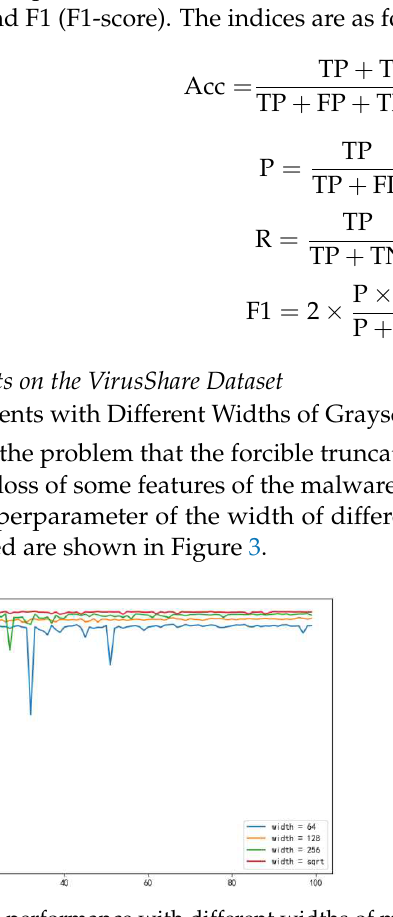
Figure 3. Model performance with different widths of malware grayscale images.